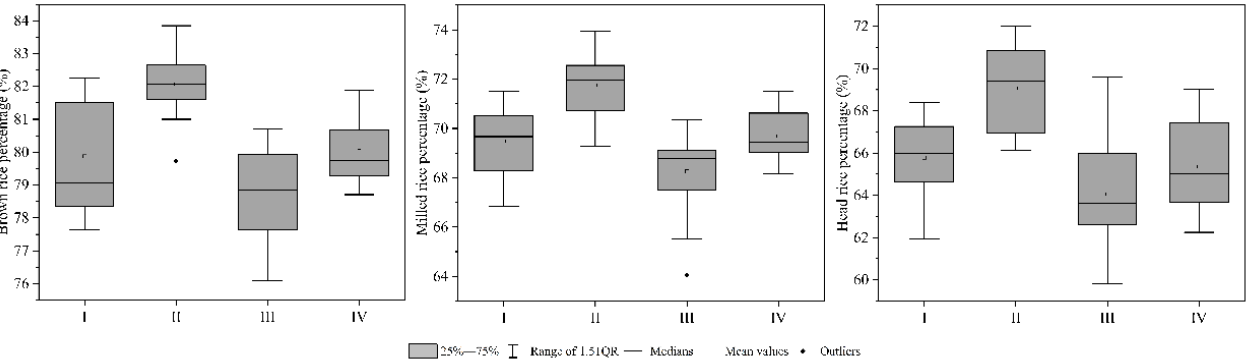
Figure 3. Milling quality of rice.